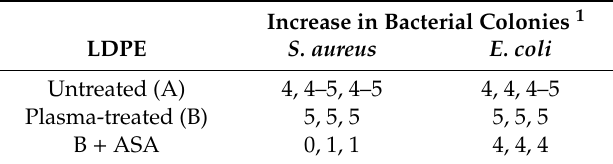
Table 3. Antimicrobial activity of LDPE samples.